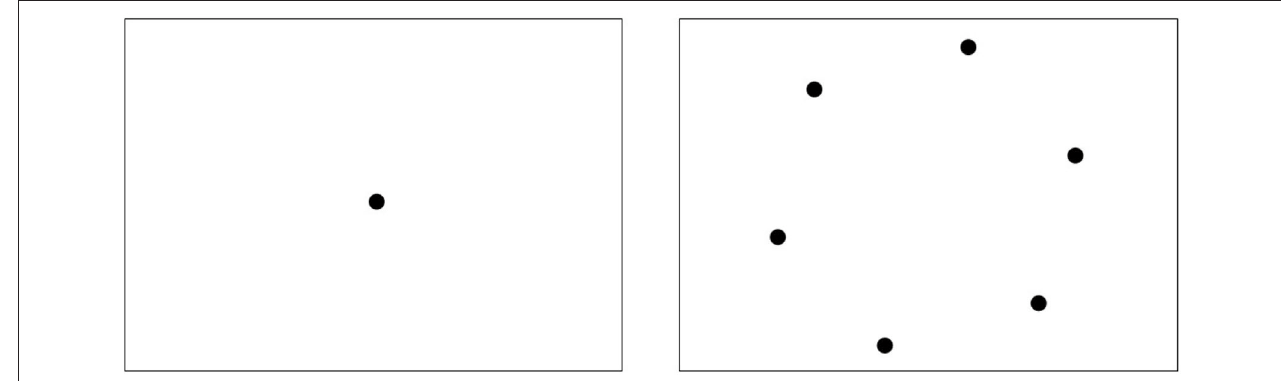
FIGURE 1 | Experimental materials. Illustrations of the visual stimuli for the 1-target (left), and the 6-target conditions